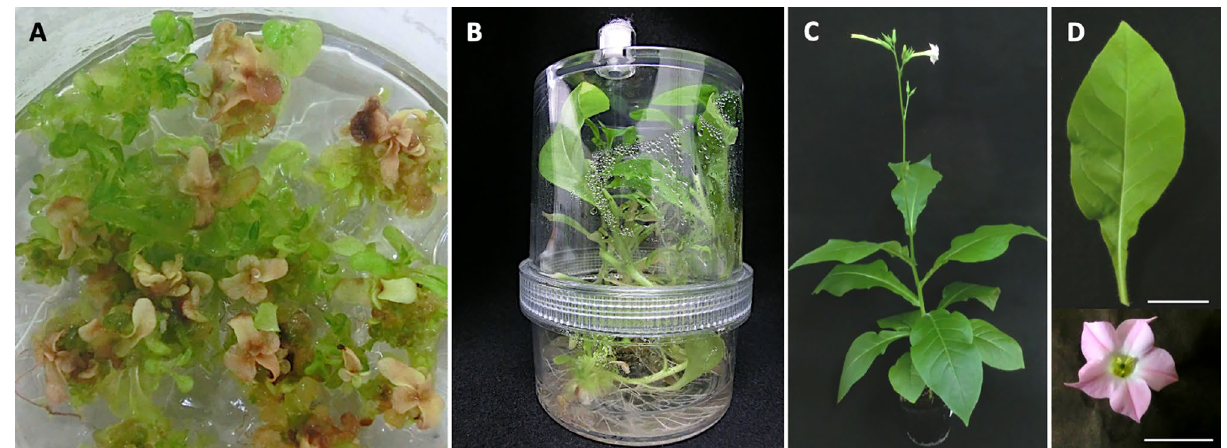
Figure 4. Process of obtaining hybrid regenerated plants not showing lethality. ( A ) Viable shoots formed on hybrid seedlings cultured on medium supplemented with 2.0 mg/L 6-benzylaminopurine (BAP). ( B ) Regenerated plants from viable shoots propagated in a plant box. ( C ) Matured regenerated plant. ( D ) Leaf and flower phenotype of one regenerated plant. Scale bar: 2